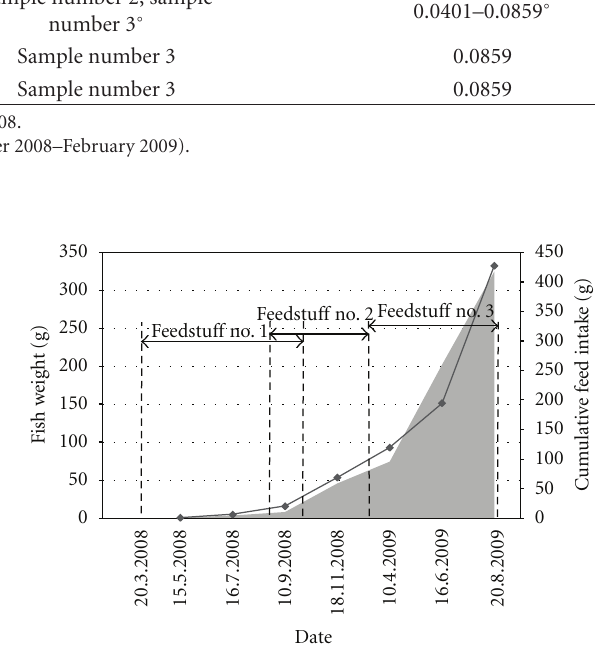
Figure 3: Fish growth curve (solid line), cumulative feed intake (grey area), and feeding period of di ff erent feedstu ff